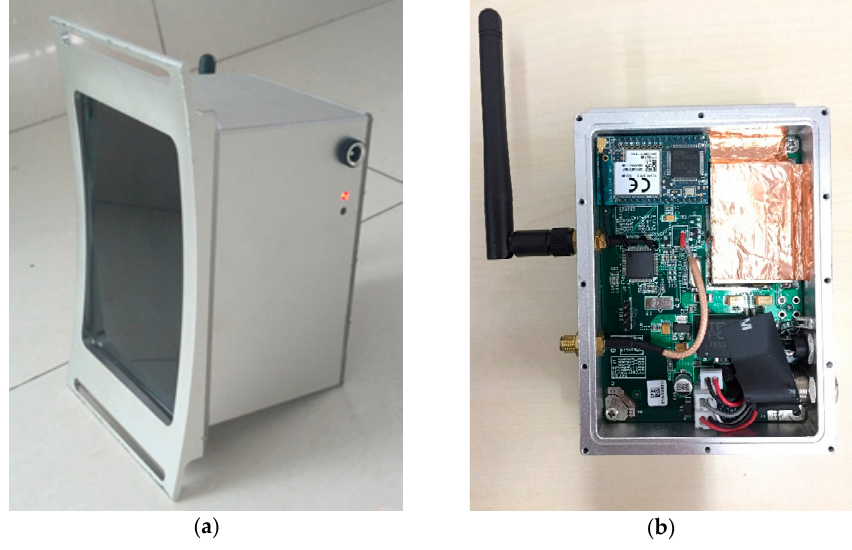
Figure 6. The picture of wireless Ultra-High Frequency (UHF) sensor. ( a ) Outside; ( b ) Inside.